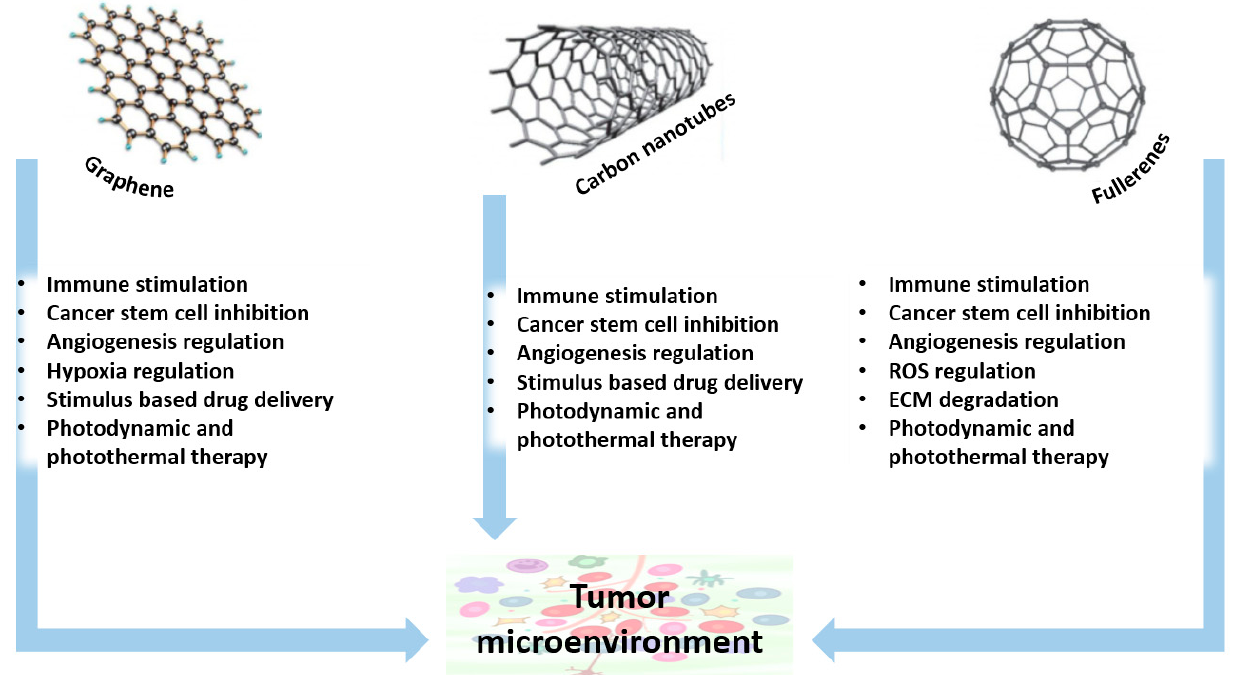
Figure 4. The role of Carbon-based nanomaterials in TME-targeted cancer therapy. Adapted with permission from [44]. Copyright 2018, John Wiley and Sons. Abbreviations: ECM—extracellular matrix; ROS—reactive oxygen species.